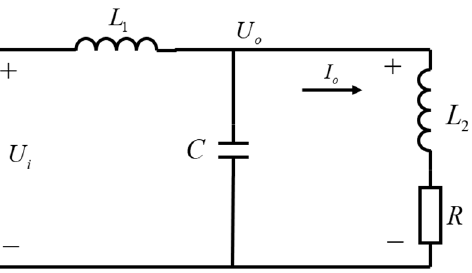
Figure 3. Synchronous rectification-type buck circuit structure diagram.